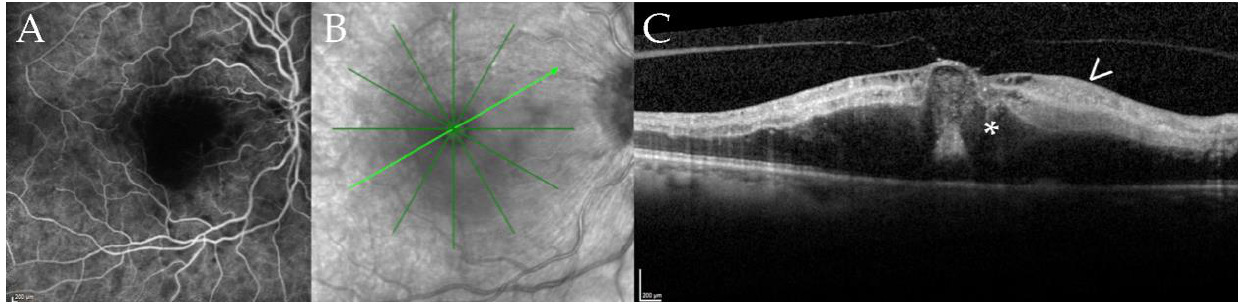
Figure 4. Cilioretinal vessel occlusion in a 67-year-old patient with disseminated Mycobacterium chimaera infection. Fluo- resceine angiography (FA, panel ( A )), near infrared imaging (NIR, panel ( B )), optical coherence tomography B-scan (OCT, panel ( C )) of case 12 at 18 months of follow-up. Panel ( A ) shows a filling defect of the cilioretinal vessel in the early frames of the FA; the inferotemporal and superotemporal arteries are already filled. Panel ( B ) shows the NIR image with the location of the B-scan (light green arrow) shown in panel ( C ). Note the defocusing of the macular region. The corresponding B-scan (Panel ( C )) demonstrates hyperreflectivity of the inner retinal layers (arrow) and macular edema (asterisk) secondary due to ischemia after cilioretinal vessel occlusion.